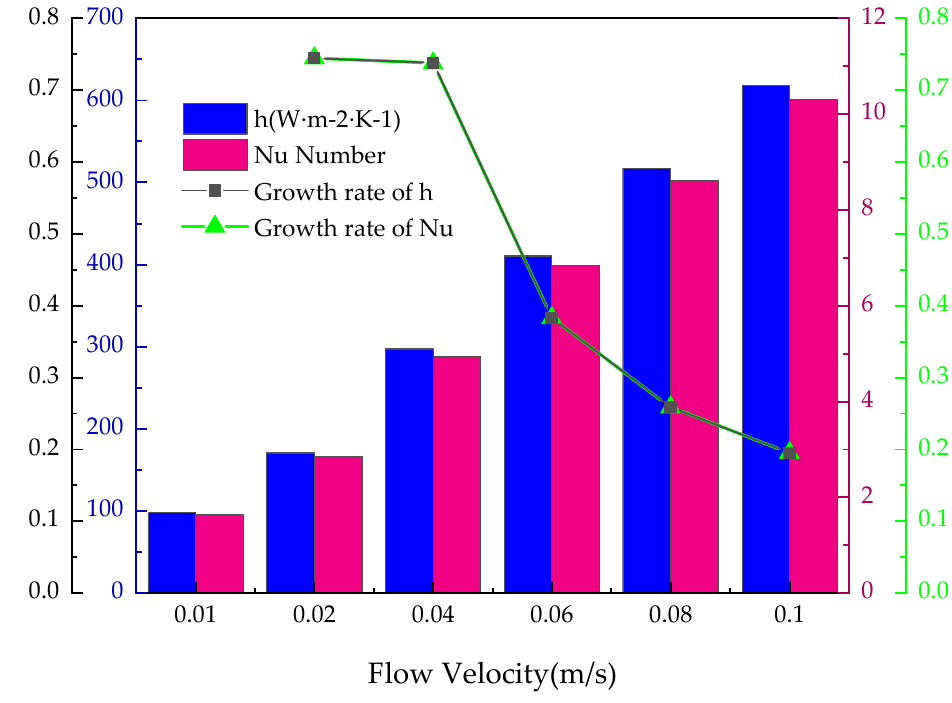
Figure 9. Effect of flow velocity on h and Nu. Therefore, we also find that in fluid-based BTMS, the flow rate of fluid should be lower. This ensures that the BTMS does not break under too much pressure and allows the fluid flowing into the BTMS to spend more time in indirect contact with the battery, bringing in or taking away more